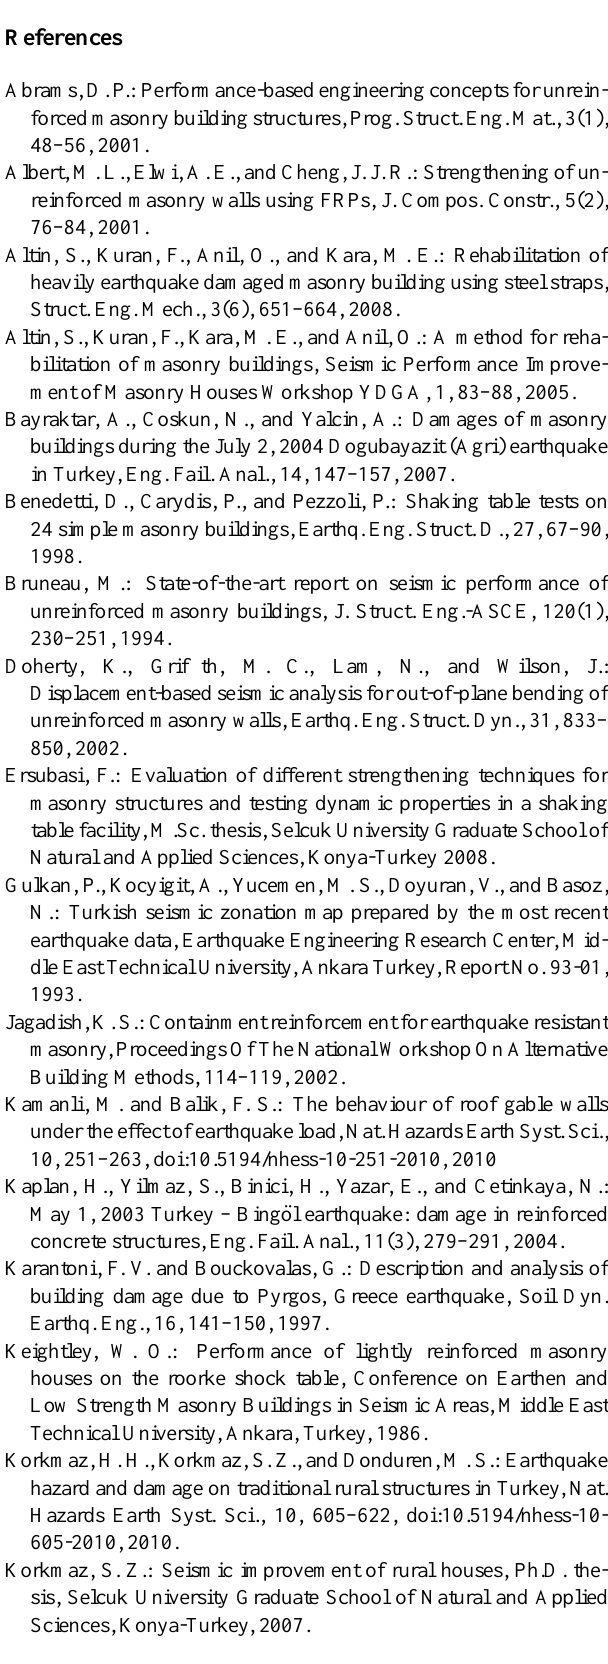
F. Ersubasi and H. H. Korkmaz: Shaking table tests on strengthening of masonry